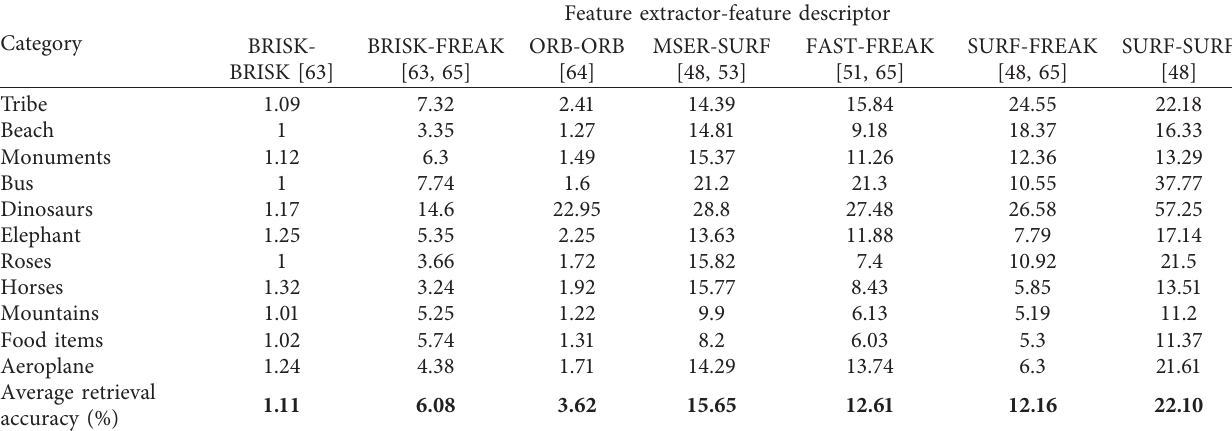
Table 4: Average image retrieval accuracy using various feature extraction and description techniques for the augmented Wang